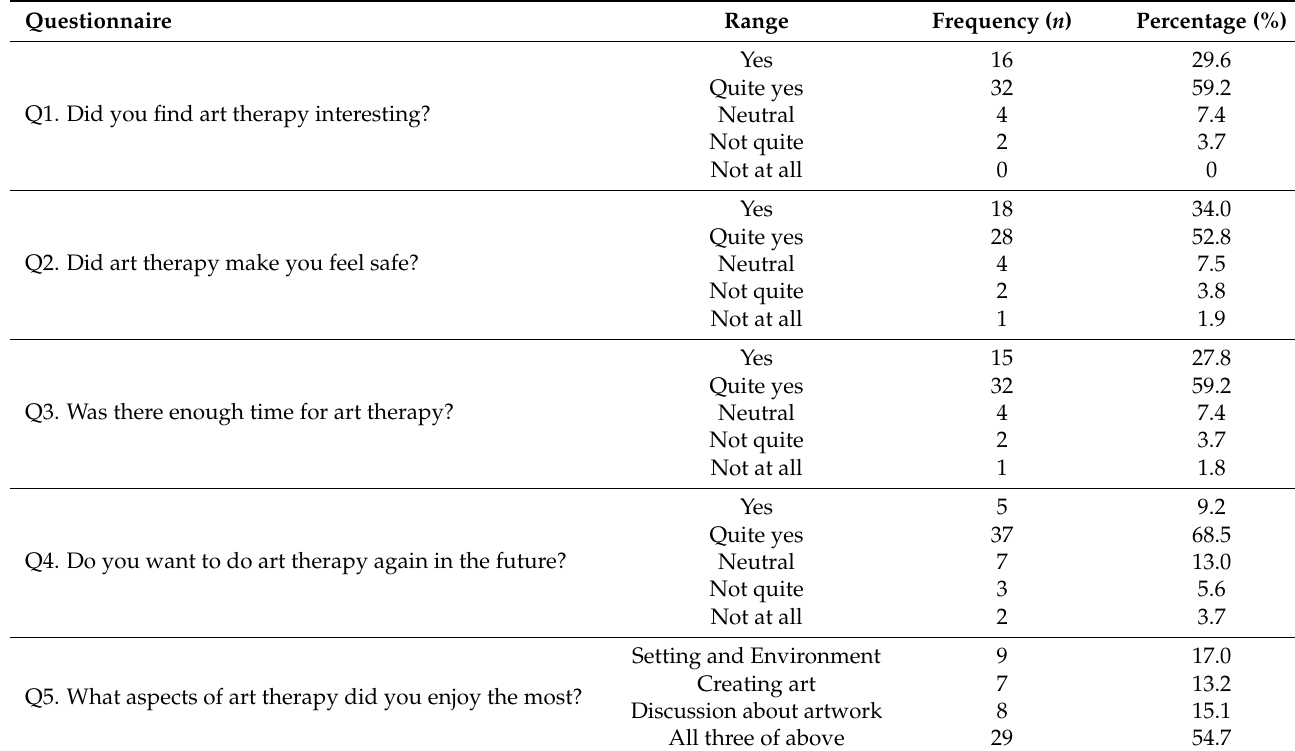
Table 4. Satisfaction of art therapy.